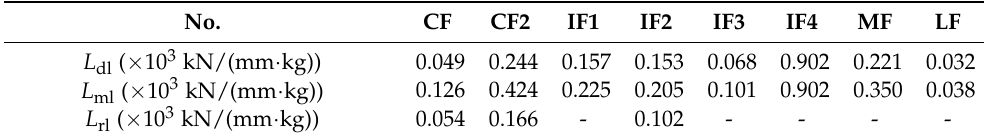
Table 7. The bond loads on per embedded length of per unit weight steel fibers. No. CF CF2 IF1 IF2 IF3 IF4 MF